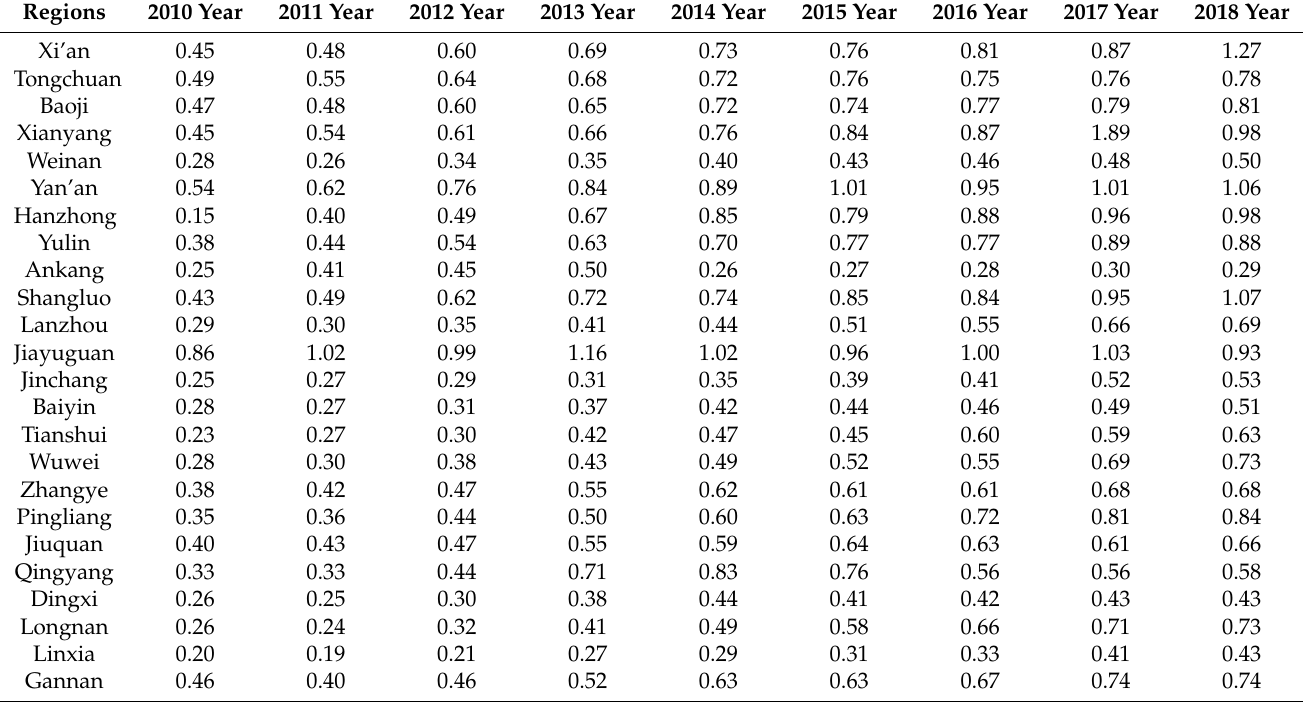
Table A2. The AWUE in China from 2000 to 2018 (continued from Table